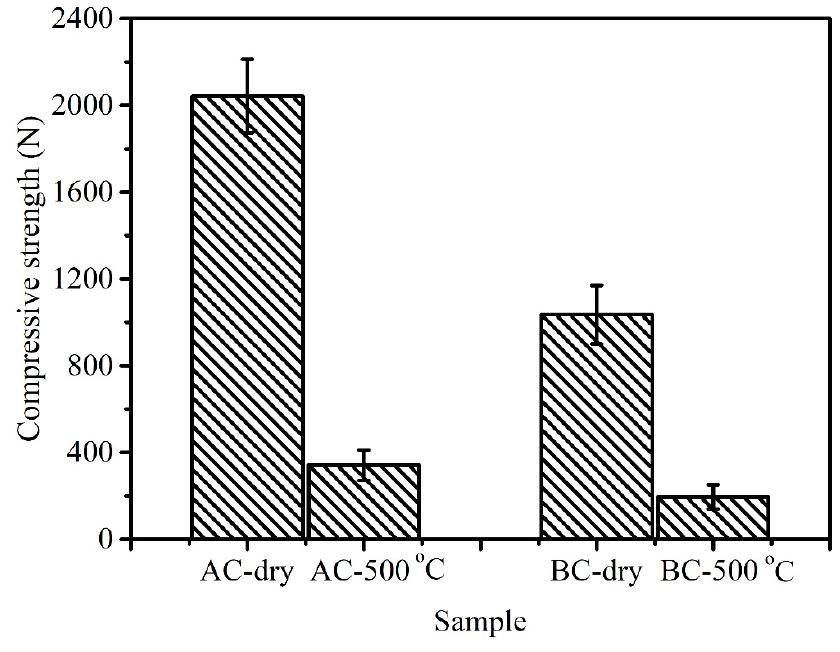
Figure 9. Compressive strength of the dry and heat ‐ treated (at 500 °C for 30 min) CBBs. In order to better understand the change characteristics of compressive strength, typical compressive strength curves of two CBBs are shown in Figure 10. The change trend of compressive strength curves of sample AC before and after heat treatment at 500 °C are the same as those of sample BC. Both continuously increase during the process of applying compressive force and then decrease after reaching the peak. There are four characteristic stages in the development of the macroscopic failure process of intact CBBs: stage I: crack closure and elastic stage (OB), stage II: stable crack growth (BC), stage III: initiation of macro-scale shear failure (CD) and stage IV: instability propagation (DE) [21,22]. The difference between the dry and heat-treated sample during the macroscopic failure process is the instability propagation (DE) of stage IV. There is an obvious turning point (as shown in the blue circle in Figure 10a) on the curve; furthermore, there is even a transition platform on sample BC’s curve. However, there is no turning point (as shown in Figure 10b) on the curve. These findings suggest that the bonding strength of the binder decreases after heat treatment, and CBBs will produce more fine particles during the stages of instability propagation (DE). Figure 11 describes the development of the macroscopic failure process of the dry sample and heat-treated sample during the compressive strength test.